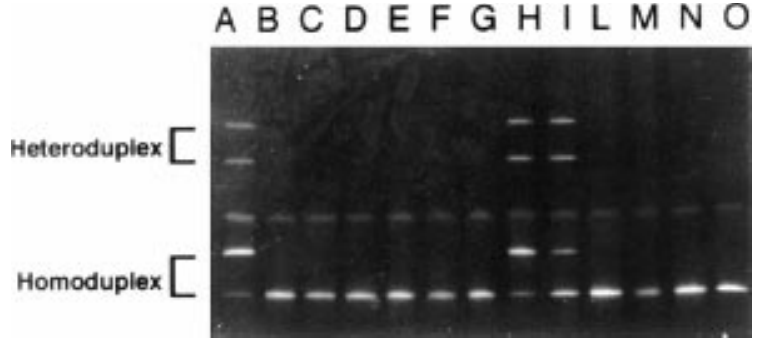
Fig. 2. PCR-based DGGE analysis examples of exon 8 of the p53 gene. A positive control obtained from the p53 mutated cell line SW480 mixed with normal lymphocyte is shown in lane A. A negative control obtained from normal lymphocytes DNA [7] is shown in lane O. DGGE variants corresponding to the adenomatous and carcinomatous components of the colorectal adenoma containing early cancer listed in Tables 1 and 3 under N. 22 are shown in lanes H and I.